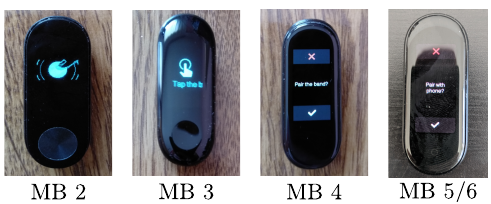
Figure 3: Mi Bands pairing confirmation messages. To accept pairing, a user must either press a hardware button (Mi Band 2/3) or touch a software button (Mi Band 4/5/6). Note that Amazfit Cor 1/2 use similar pairing confirmation